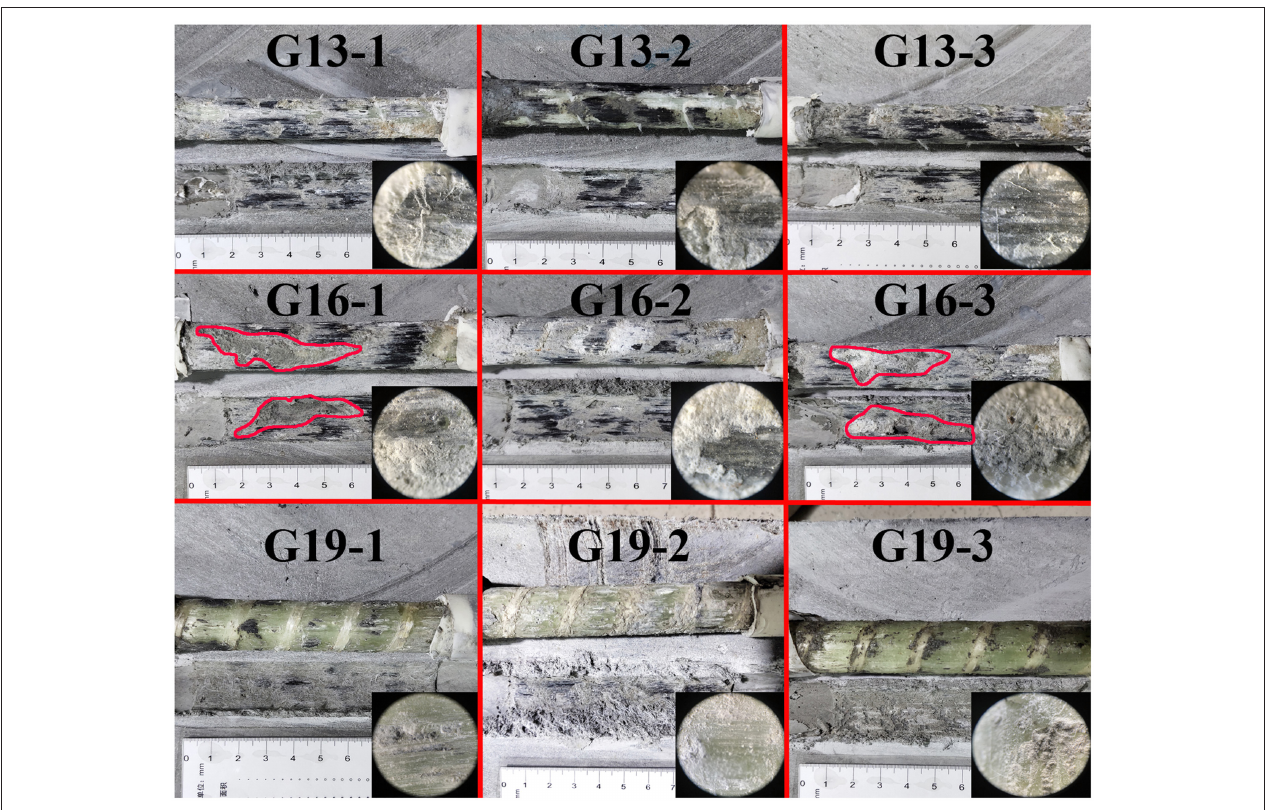
FIGURE 4 | Interfacial damage between reinforcement and